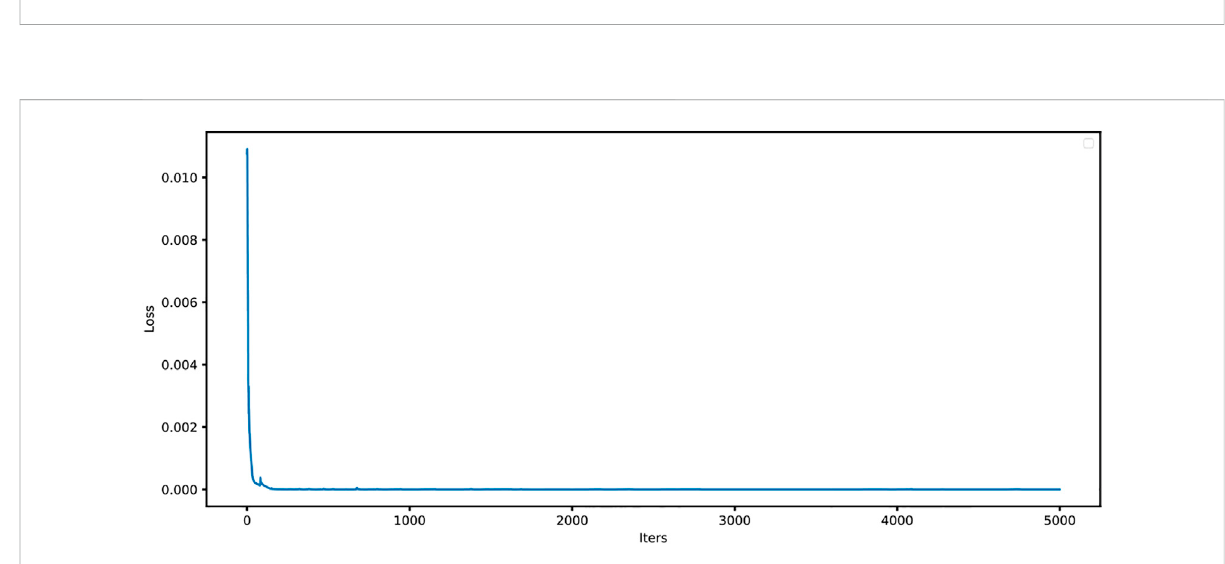
FIGURE 8 Convergence history of